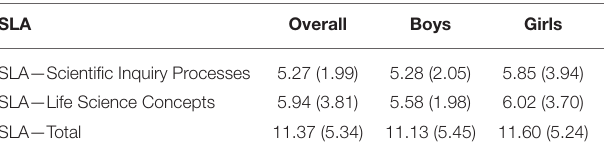
TABLE 1 | Descriptive statistics for the Science Learning Assessment of the Greek